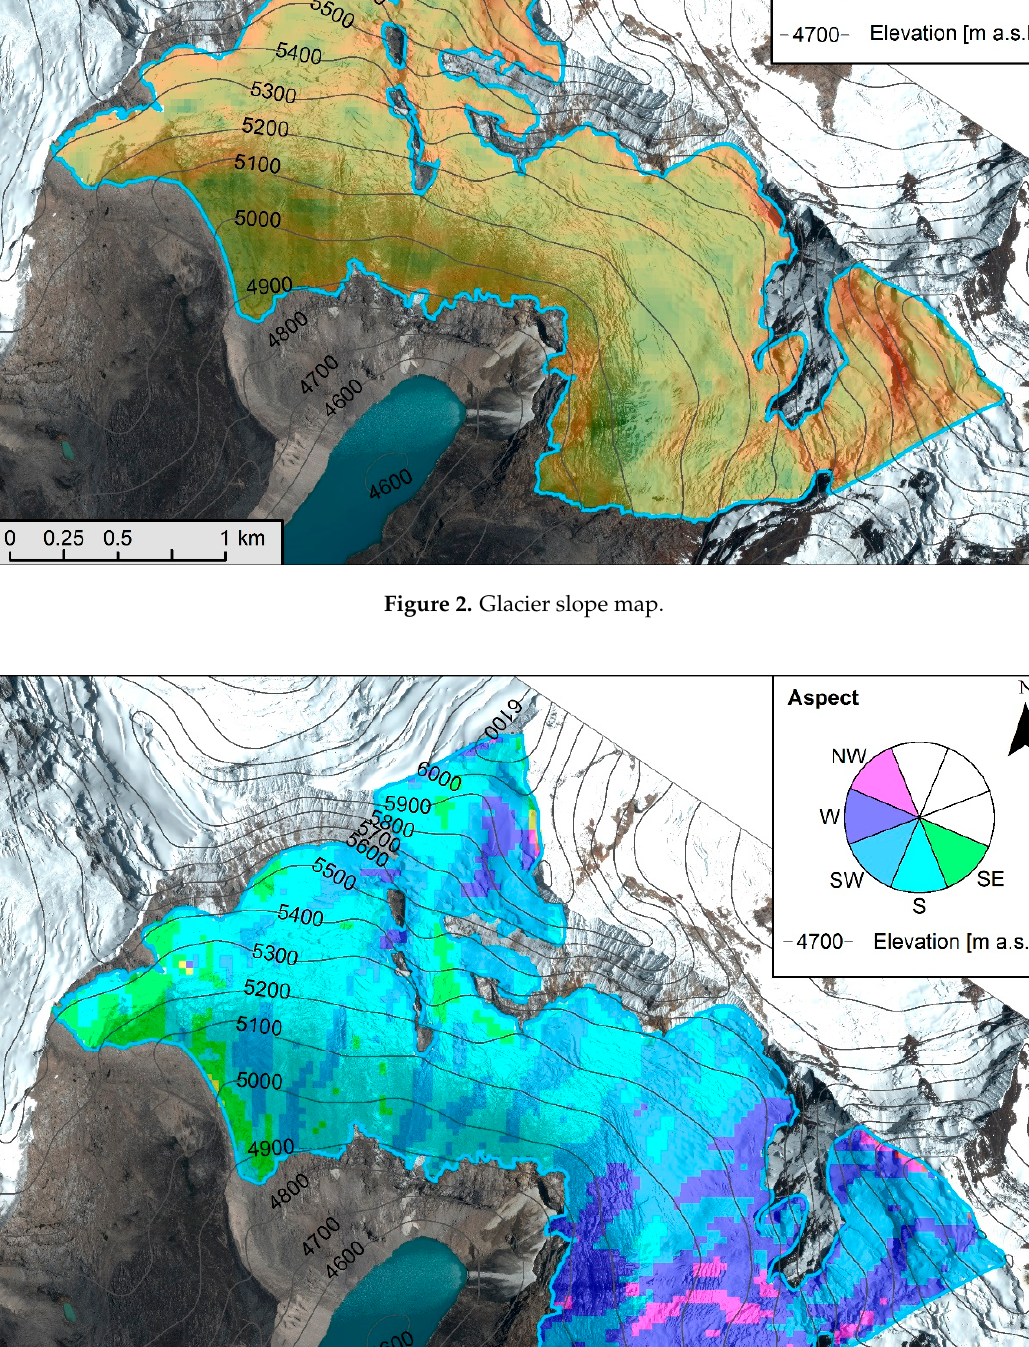
Figure 3. Glacier aspect map.